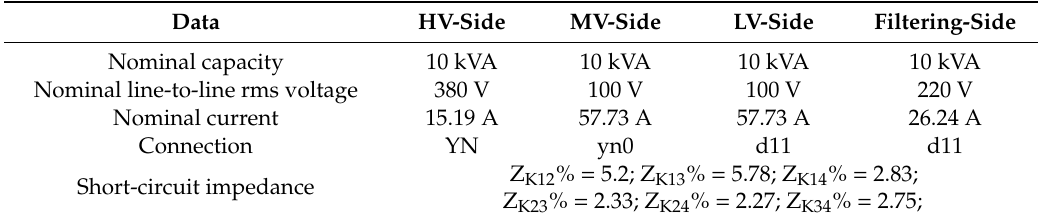
Figure 7. Components of the experimental system. Table 1. Nameplate parameters of a FW-IFT. HV: high voltage; MV: medium voltage; LV: low voltage; rms: Root Mean Square.